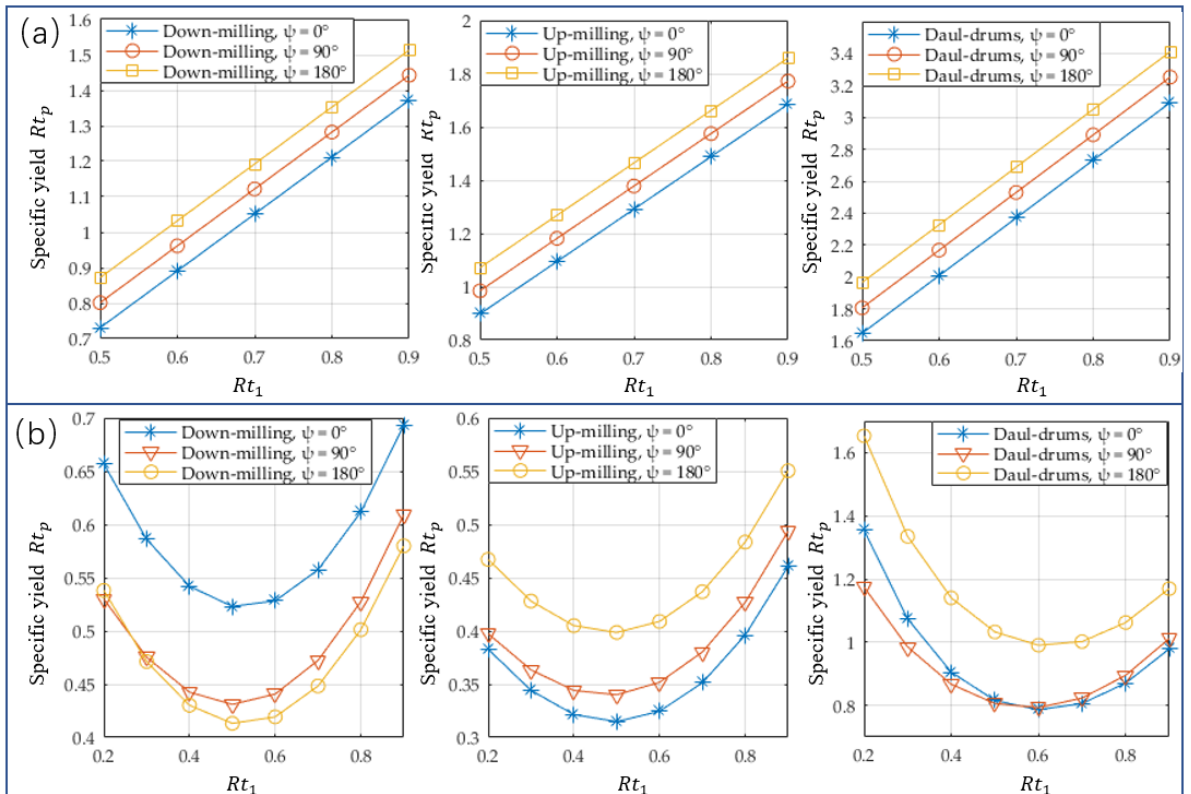
Figure 10. Influence of center of gravity position of mining vehicle on stability. ( a ) Slope stability condition; ( b ) anti-skid steering stability condition.